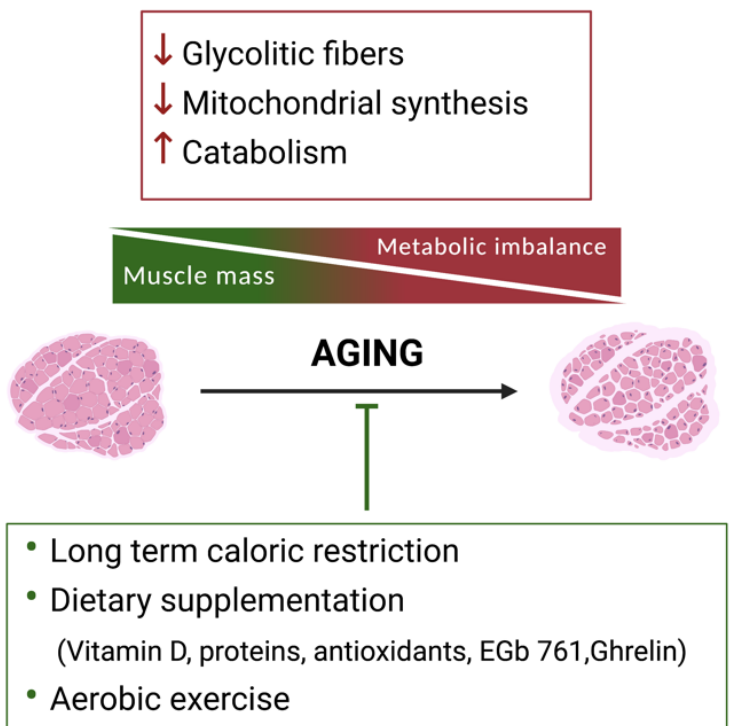
Figure 1. Metabolic reprogramming of skeletal muscle during aging and non-pharmacological approaches to counteract sarcopenia. Skeletal muscle metabolic remodeling during aging is associated with a reduction in the number of glycolytic fibers, reduced mitochondrial synthesis, and increased catabolism (red box). Decreased anaerobic glycolysis and impaired mitochondrial activity result in elevated protein catabolism and loss of muscle maintenance. Sarcopenic muscle shows reduced muscle fiber size (atrophy) and number (hypoplasia), and is accompanied by fat infiltration and connective tissue deposition. Among the main non-pharmacological approaches for the prevention of muscle mass loss during aging are long-term caloric restriction, dietary supplementation, and aerobic exercise (green